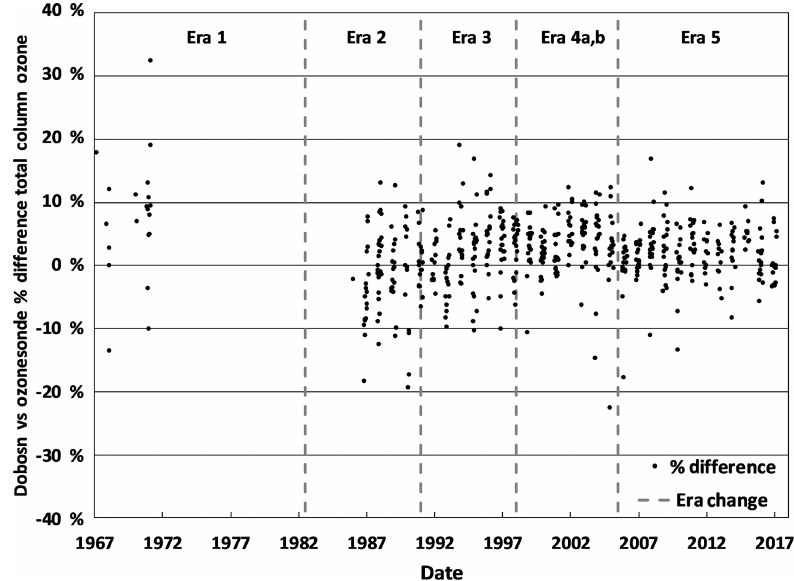
Figure 10. South Pole Dobson vs. ozonesonde total column ozone comparison.